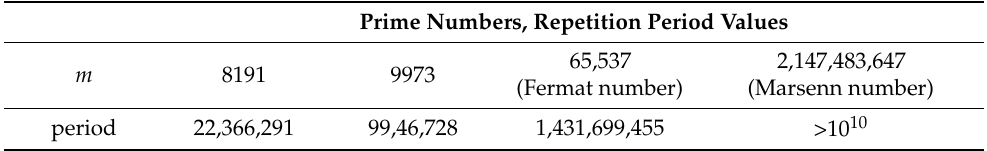
Table 2. Dependence of repetition periods of the new AFG output sequence for some m values,